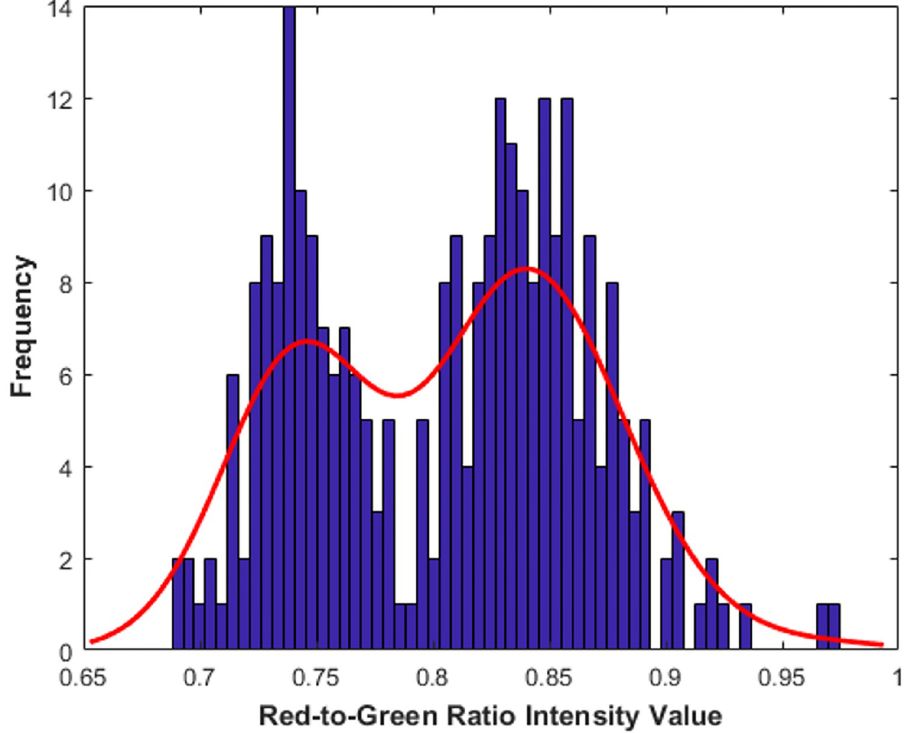
Fig 5. Example histogram of the R/G ratios in a single FOV. The red line shows the bimodal shape of the histogram, delineating what appears to be two distinct populations of WBCs (agranulocytes in the left population and granulocytes in the right